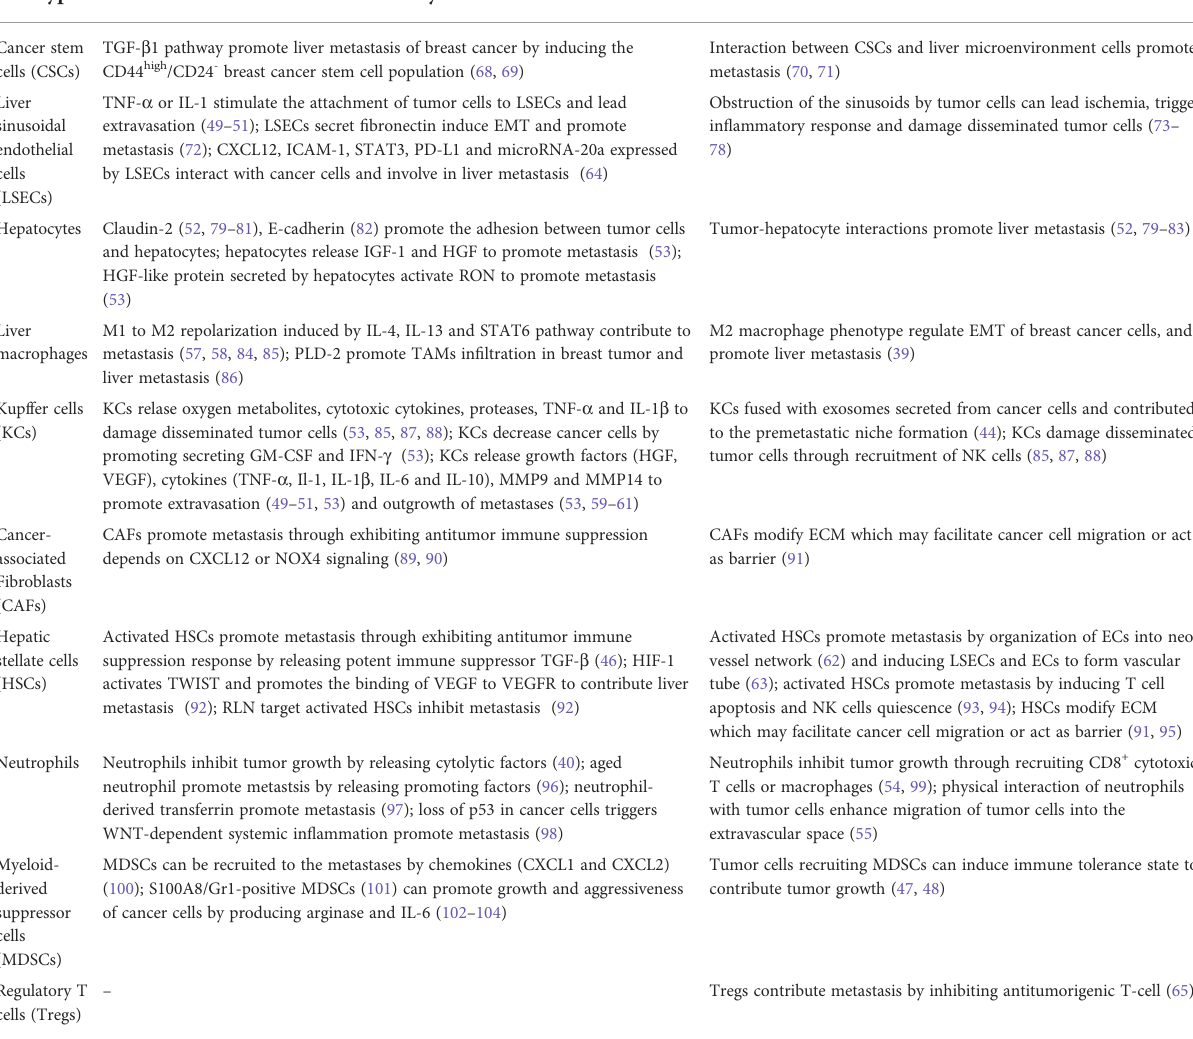
TABLE 2 The roles of different cells in the microenvironment of breast cancer liver metastasis. Cell type Molecules or cytokines Interaction with other